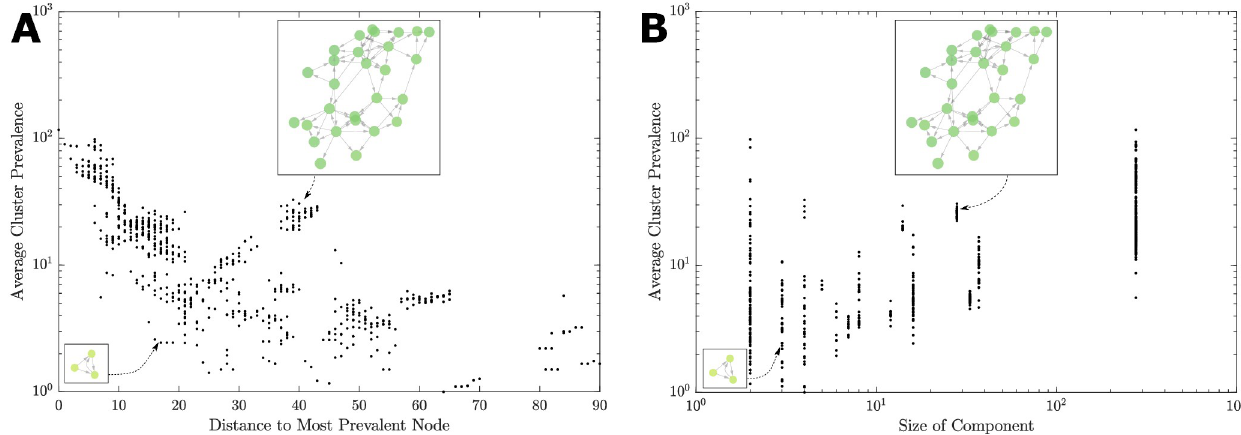
Fig 6. Prevalence as a function of the genotype network characteristics. Each point represents a node (MLVA profile), with the y-axis as the average prevalence of that profile’s undirected cluster. A: this prevalence as a function of the distance to the reference node (the orange node in Figs 2 and 3). B: each node’s prevalence is compared with the size of its connected-component in the directed network. The trend is punctuated: the prevalence increases in a step- wise fashion with decreasing distance (from successful strains), or increasing connected-component size (connectivity of the node). For the sample size of N = 690 connected nodes, the correlation between log prevalence and distance is r = − 0.613 ( N = 690, p < 0.0001) and between log prevalence and log component size is r = 0.739 ( N = 690, p < 0.0001).